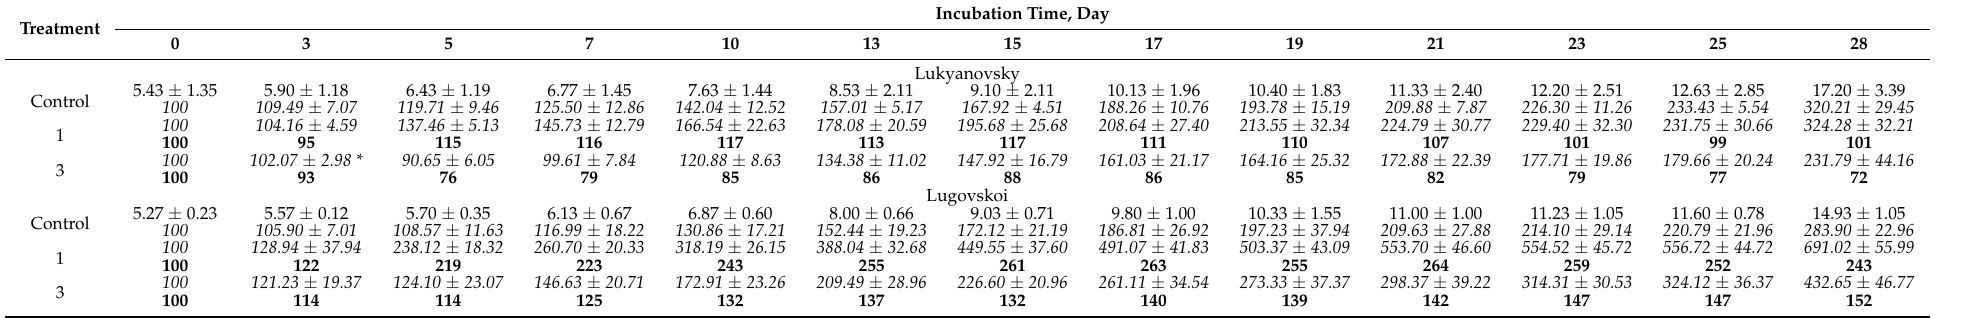
Table 1. Height of in vitro plants of Lukyanovsky and Lugovskoi potato cultivars in control (cm) and after treatment by fungal biopreparations without Se based on Grifola umbellata (1) and Pleurotus ostreatus (3) (percent of “0 day” in italic, and percent to control in